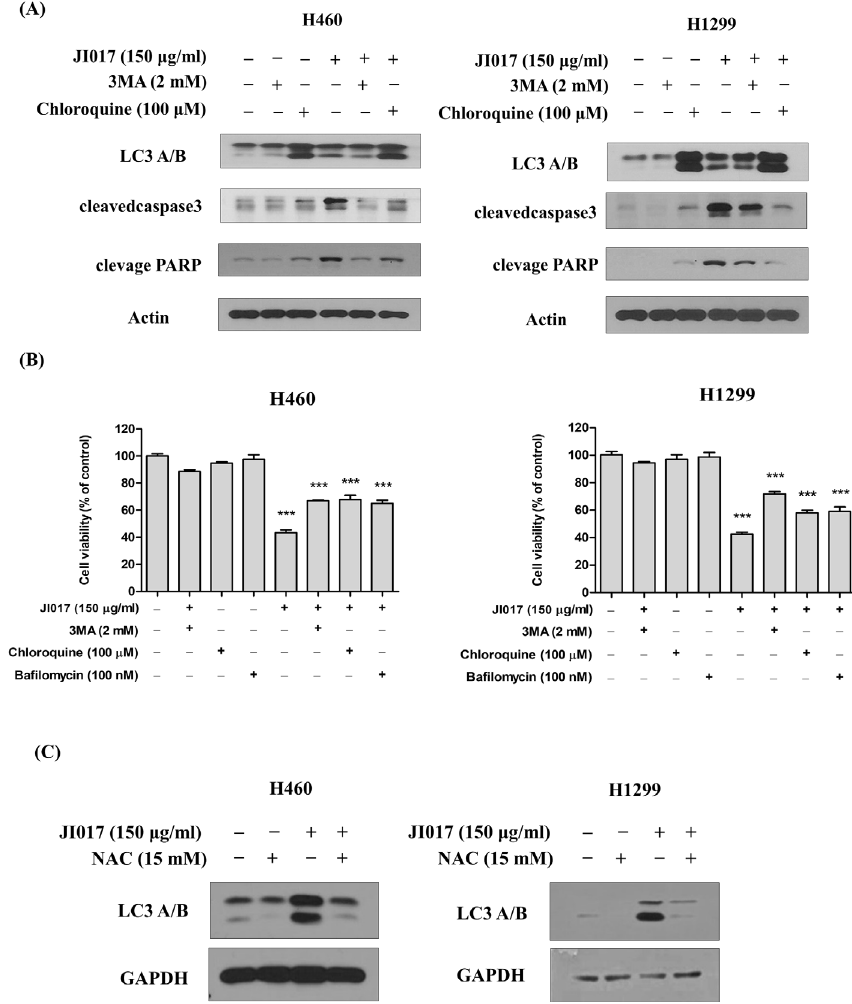
Figure 4. JI017 induced apoptosis through an autophagy pathway and ROS generation. ( A ) H460 and H1299 cells were treated with 3MA (2 mM) or chloroquine (100 µ M) combined with JI017 (150 µ g/mL). 3MA, chloroquine, or bafilomycin treatment was followed by treatment with JI017. ( B ) Cell viability was measured using MTS assay. ( C ) H460 and H1299 cells were treated with NAC (15 mM) and JI017 (150 µ g/mL). Whole cell lysates were analyzed by Western blotting with anti-LC3 and anti-GAPDH antibodies. Data are presented as the mean ± SEM. *** p < 0.001 compared to untreated